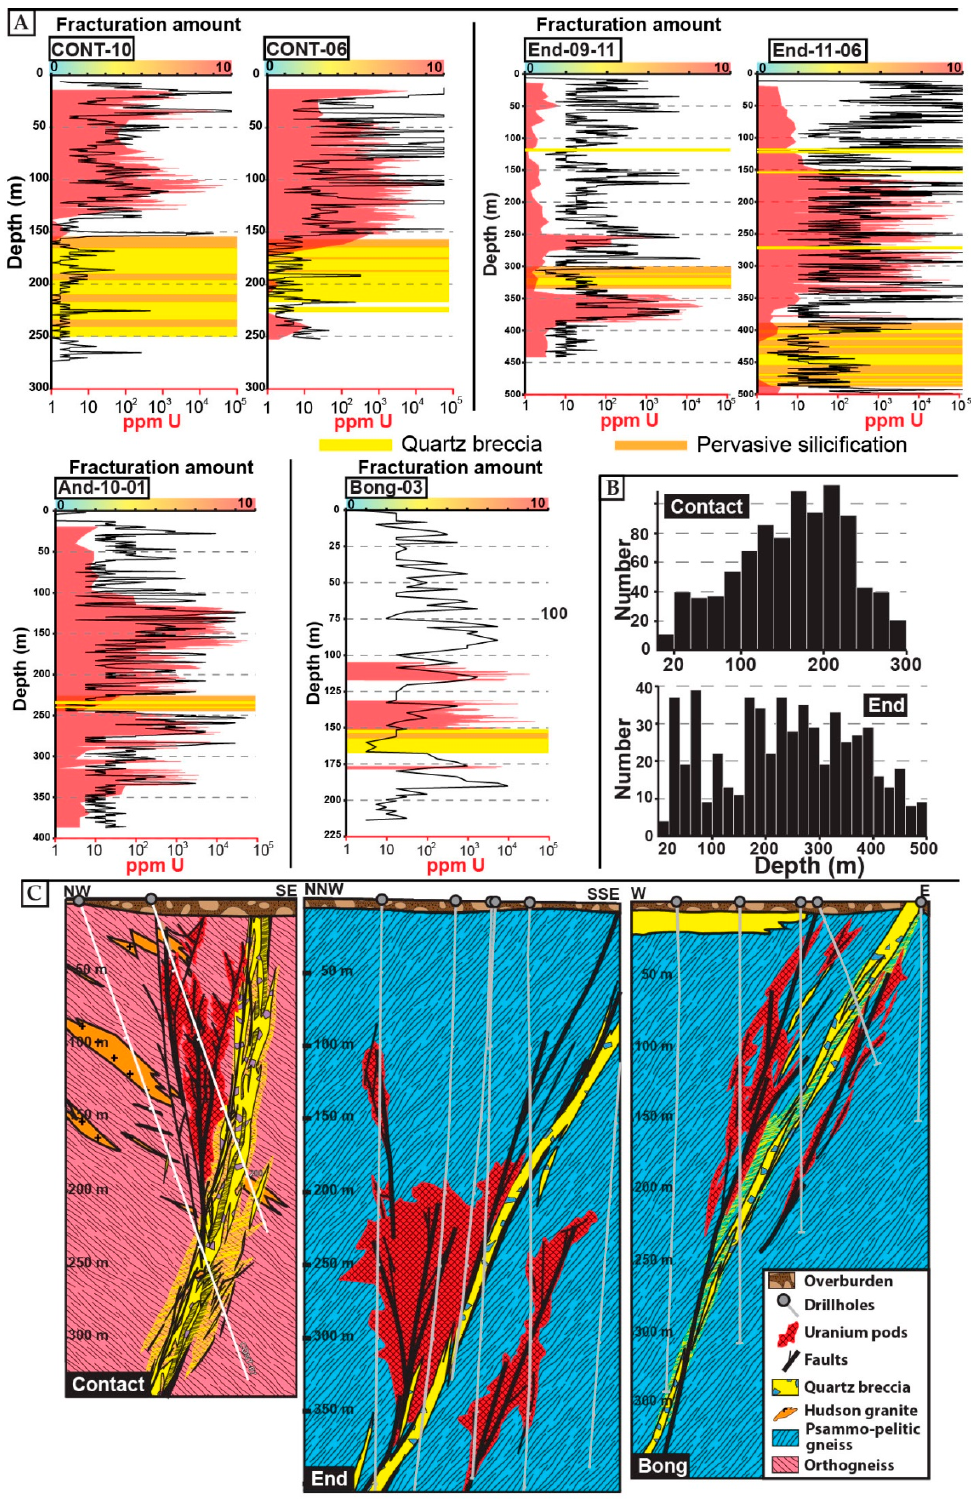
Figure 12. ( A ) Distribution of fracture density and uranium mineralization as a function of depth, for selected drillholes from Contact (Cont), End, Andrew Lake (And) and Bong. Fracture density as black lines; 0: Non-fractured drill-core, 10: Intensely fractured drill-core. Uranium mineralization in red: U in ppm measured by assays, logarithmic scale). ( B ) Number of quartz veins as a function of depth for Contact and End. ( C ) Simplified cross sections.